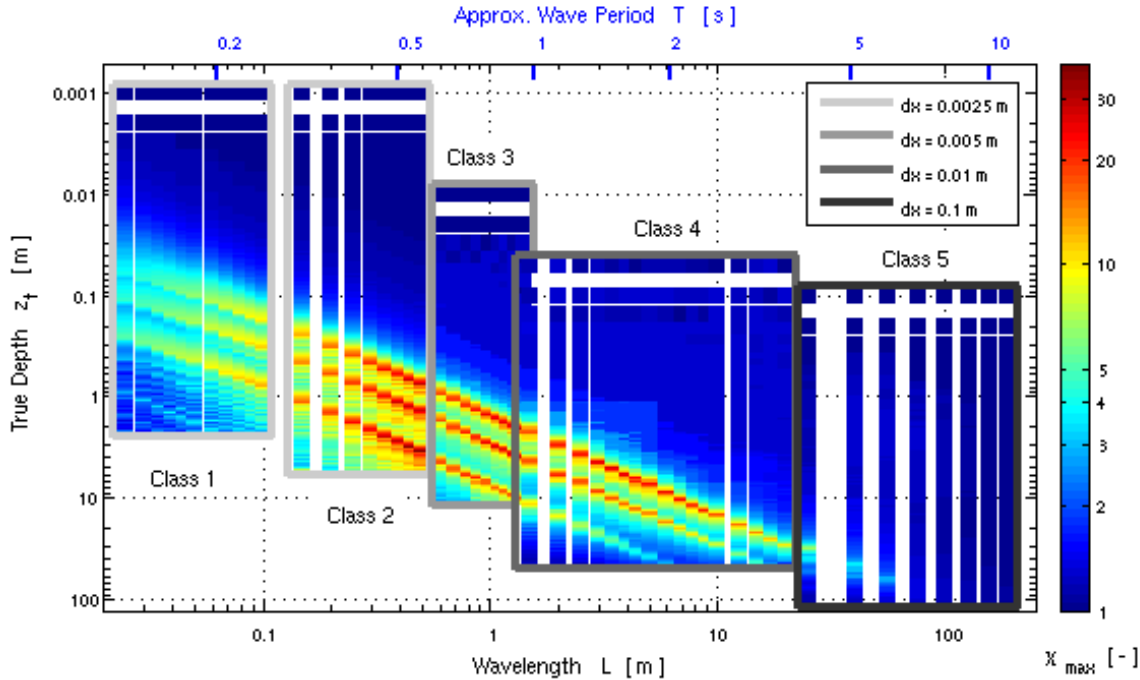
Fig. 4. Maximum possible normalized downwelling irradiance χ max due to single waves per water depth z t and in accordance with the surface wavelength L (and period T at the top); the five framed wave classes refer to different detector sizes dx (note the logarithmic color scale).